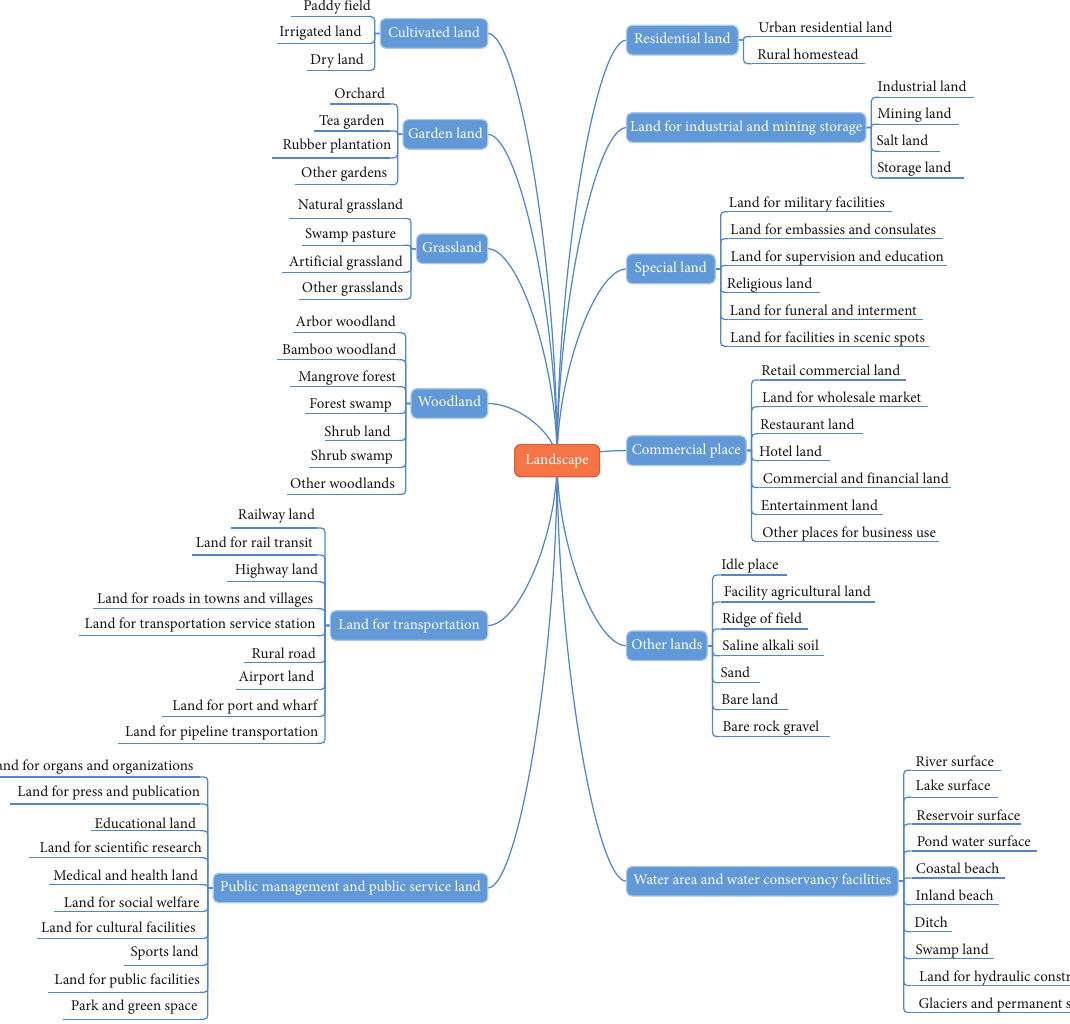
Figure 1: Part network hierarchy of land-use classification Table 2: Semantic similarity for geographic entity of land-use type ontology.